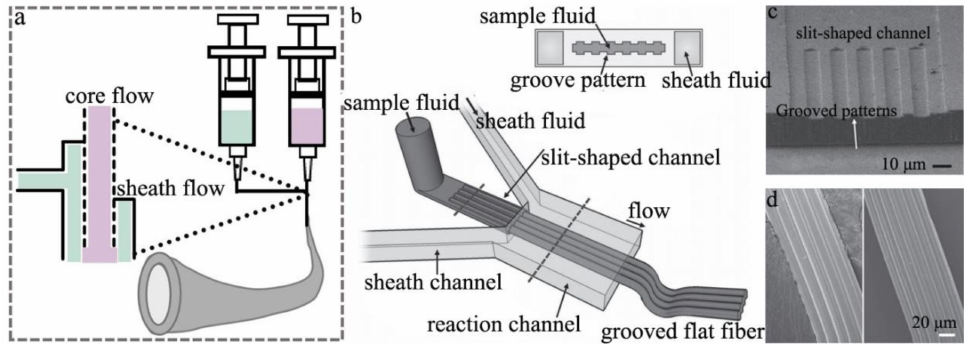
Figure 8. Schematic diagram of ( a ) microfluidic spinning system and ( b ) generating flat fibers with micro-grooves, SEM images of ( c ) the slit-shaped channel and ( d ) alginate fiber with grooved